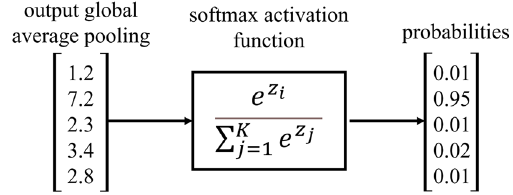
Fig. 6 SimKI softmax activa- tion